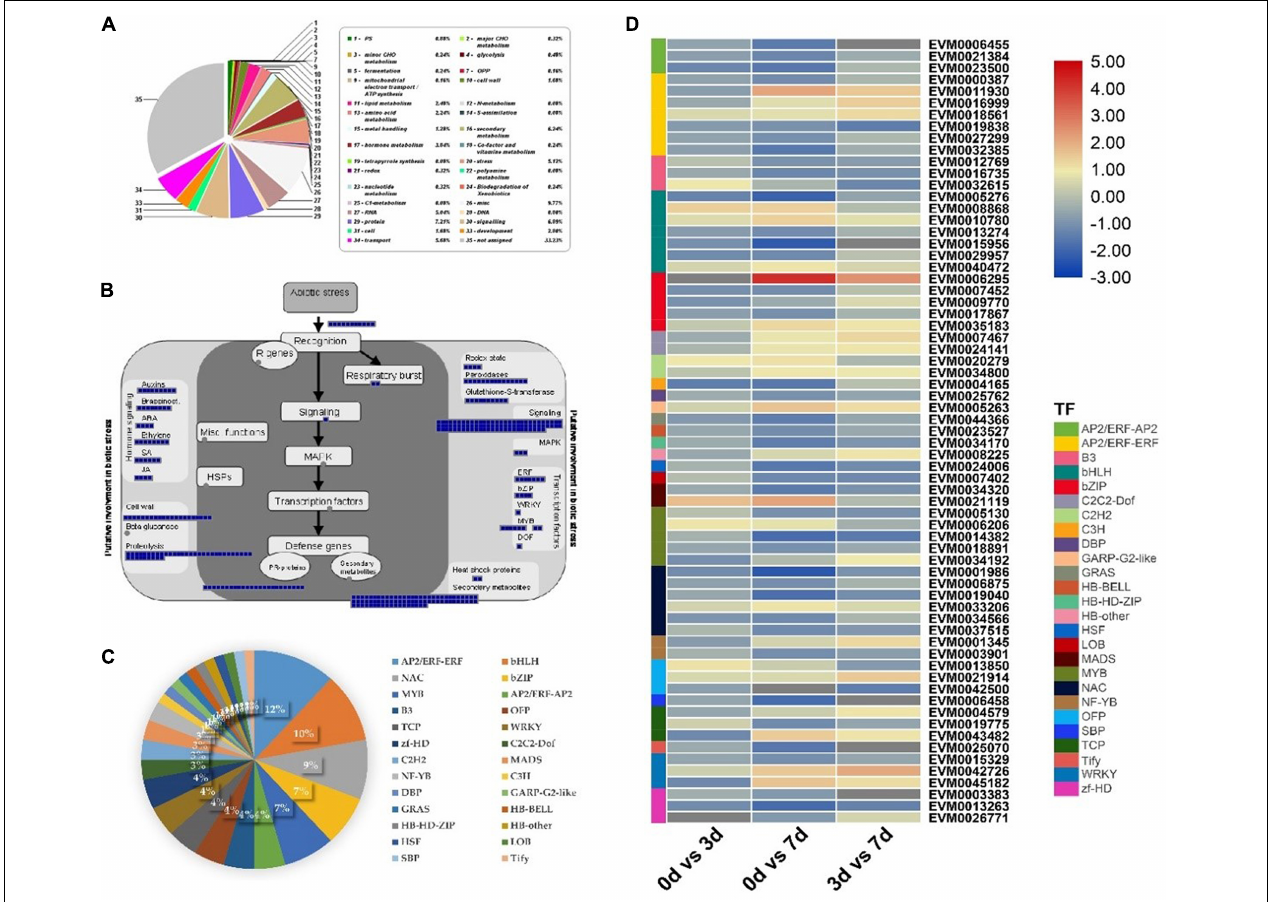
FIGURE 4 | MapMan annotations and gene expression analysis of RPY geng specific DEGs (G2 + G3). (A) Functional categories of DEGs based on MapMan annotations. (B) The MapMan biotic stress overview of RPY geng specific DEGs. (C) The transcription factors (TFs) of RPY geng specific DEGs. (D) Gene expression profiles of TF genes. Blue boxes represented genes were differentially expressed on day 3 or/and on day 7 after salt stress treatment in panel (B) . The percentage of different TFs in the total TFs was represented by pie chart in panel (C) . The high-resolution of this figure was provided in Supplementary Figure 2